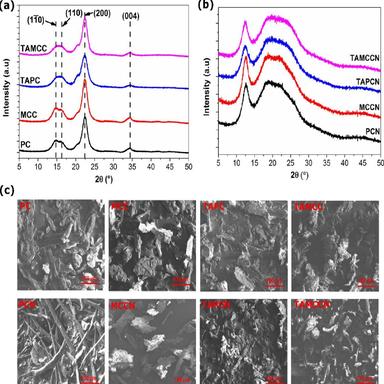
(a) X-ray diffractograms of functionalized samples and their precursors; (b) X-ray diffractograms of nitrated polymers; (c) SEM micrographs of functionalized samples and their precursors before and after nitration.